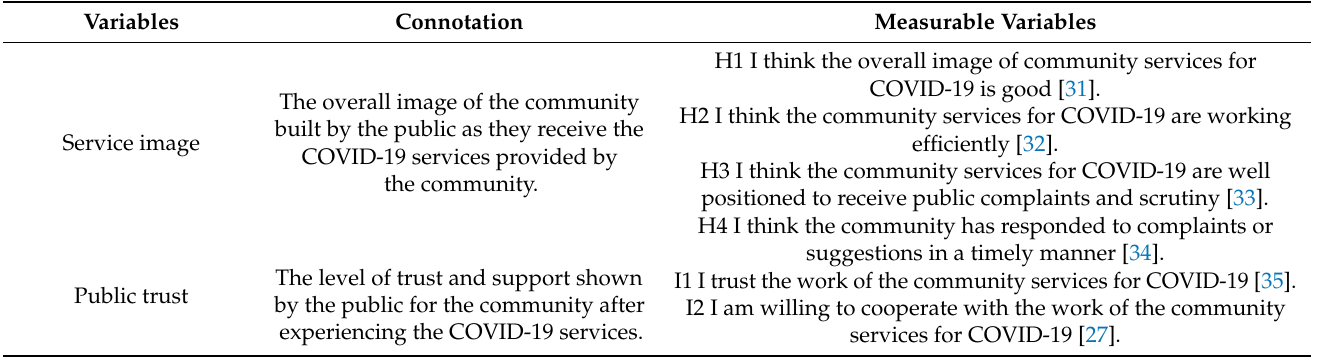
Table 5. Connotation and measurable variables of service image and public trust.